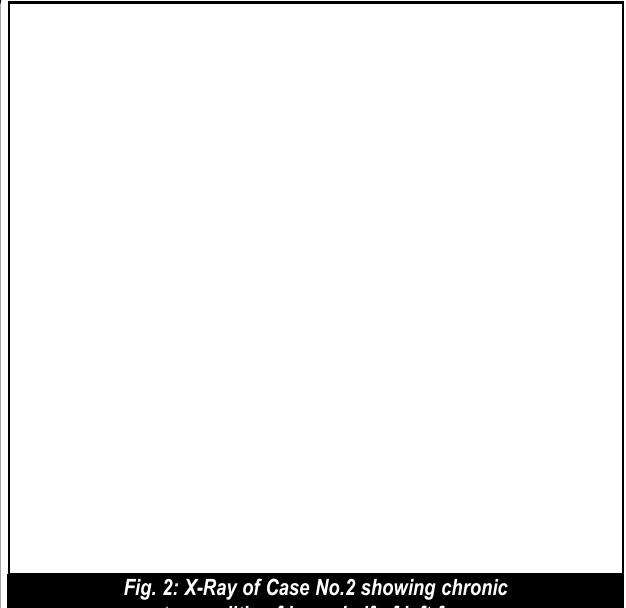
Fig. 2: X-Ray of Case No.2 showing chronic osteomyelitis of lower half of left femur.